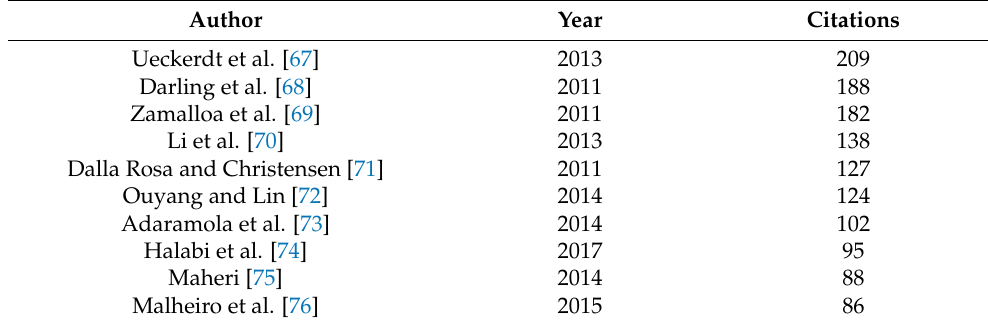
Table 7. Most Cited Papers (LCOE).